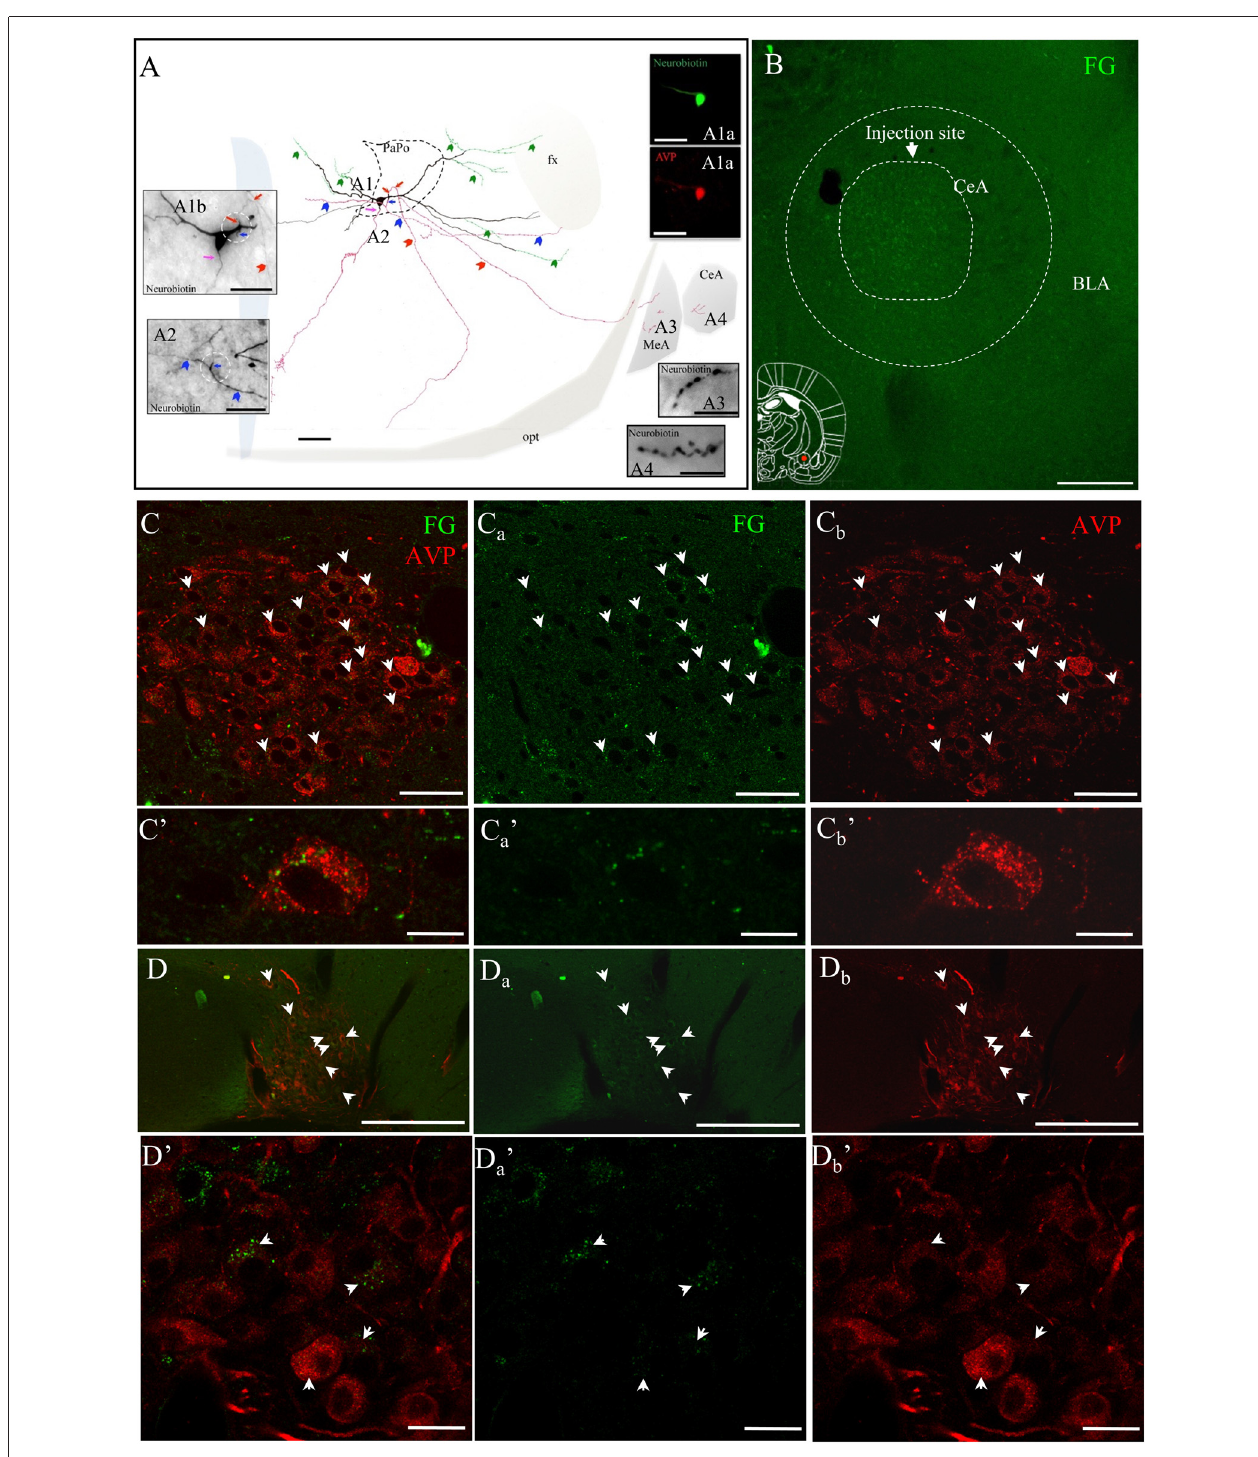
FIGURE 5 | AVP-containing magnocellular neurons innervate the CeA. (A) Camera lucida reconstruction of the coronal projection and corresponding photomicrographs (insets) showing the dendritic and axonal patterns of an anterogradely labeled AVP-containing magnocellular neurosecretory neuron sending axon collaterals to the medial and CeA. This panel was modified from Hernández et al. (2015), see the original publication for method descriptions. Red, blue and pink arrows indicate the origins of three parent-axons. Red and blue arrowheads indicate the subsequent axonal branches. The green arrowheads indicate the beaded processes originated from the dendritic processes, some of them entering the fornix (green arrowheads). Such processes were described in an early study and were considered as axonal processes (Sofroniew and Glasmann, 1981). (A1a) AVP-containing nature was ascertained by AVP